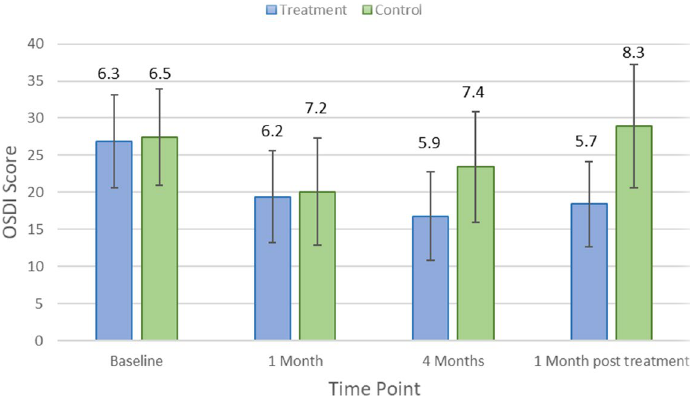
Figure 1. Mean Ocular Surface Disease Index (OSDI) score at each study time point in the treatment and control groups. Error bars are 95% confidence intervals.